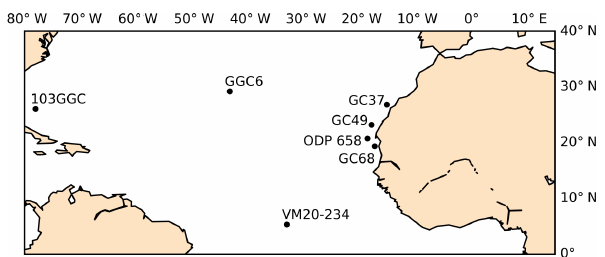
Figure 4. Site locations of marine sediment cores in the North At-